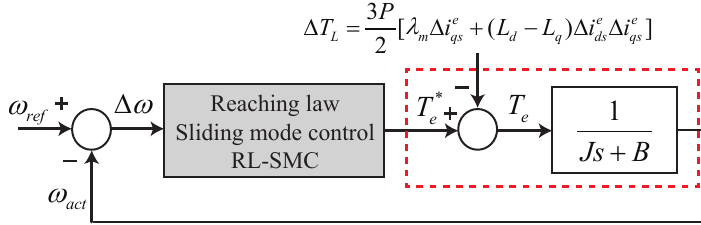
Figure 2. Speed control block